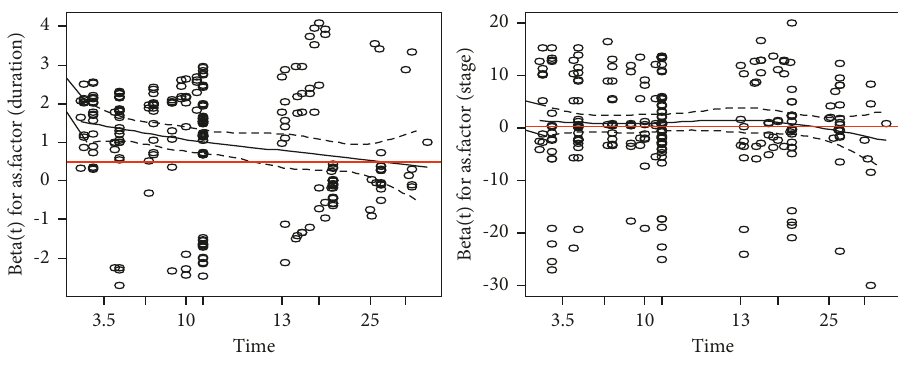
Figure 3: Test of proportionality of hazard ratio.